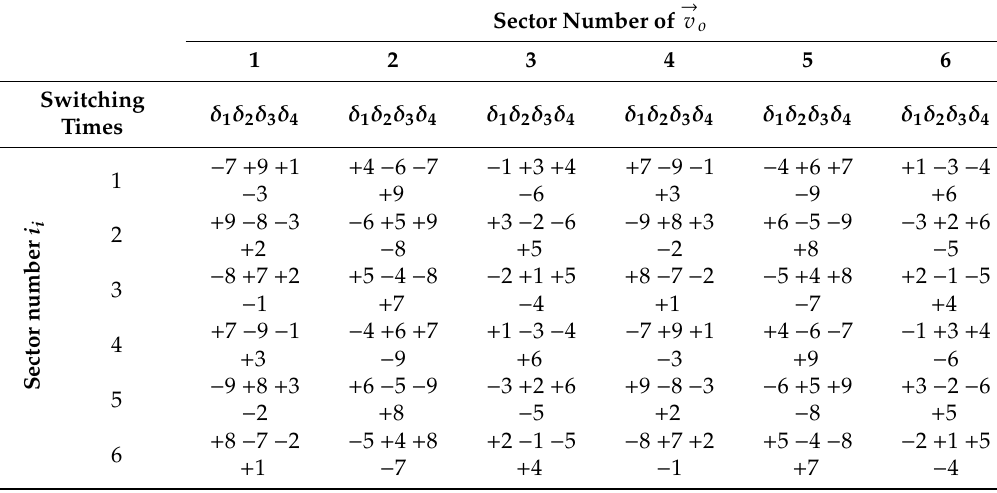
  → → v and sectors. v o and i i sectors. Table 2. Stationary vectors selected by SVM for each o i i